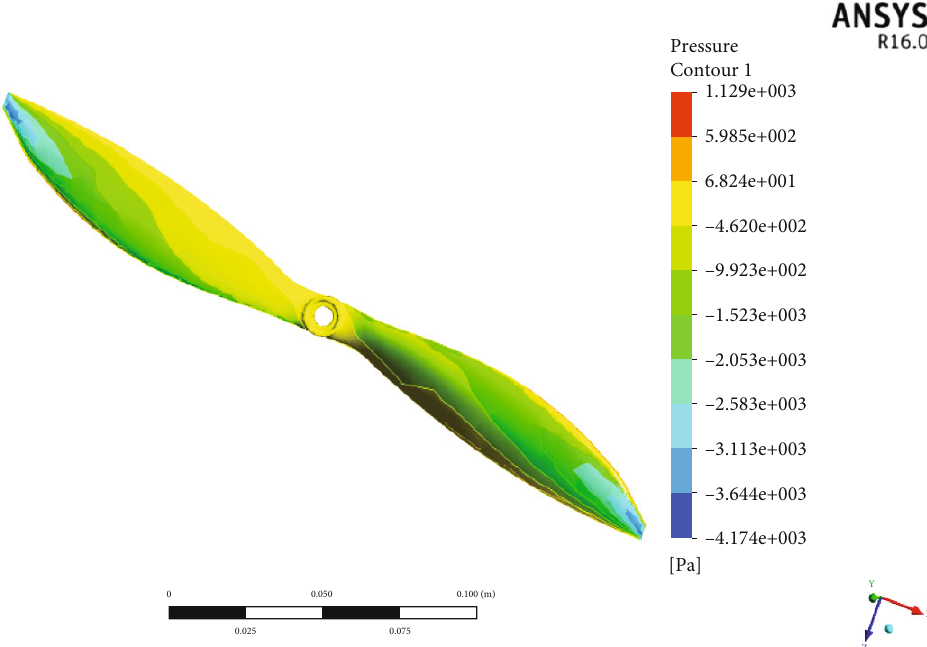
Figure 22: Pressure contour at -75 ° C